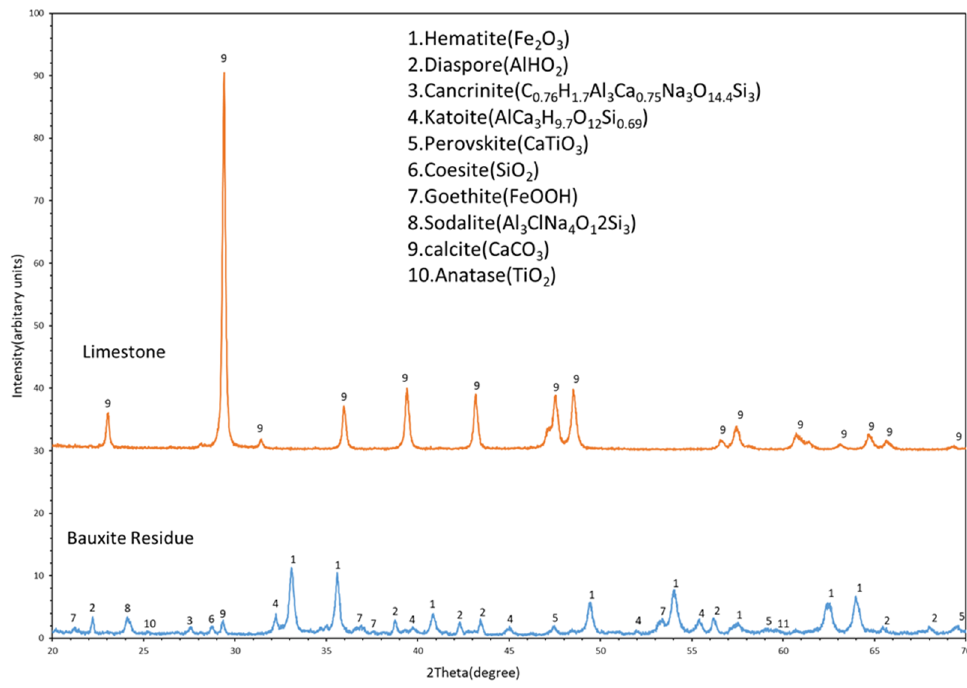
Figure 4. XRD patterns of the bauxite residue and limestone with the identified phases.